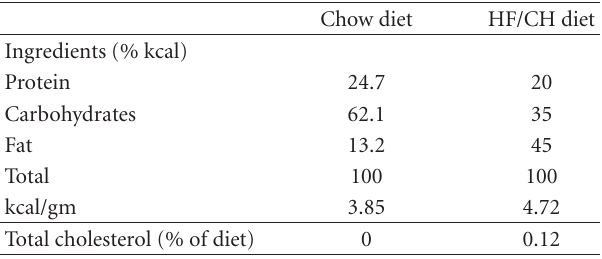
Table 1: Composition of rodent